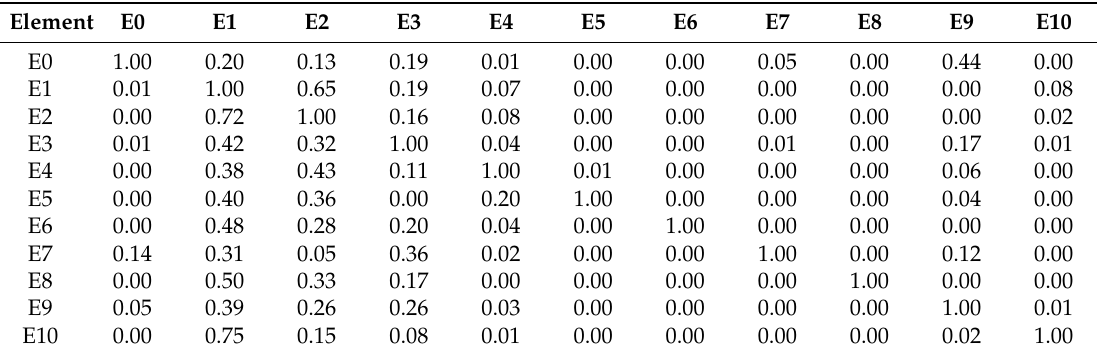
Table 3. Cooccurrence probability